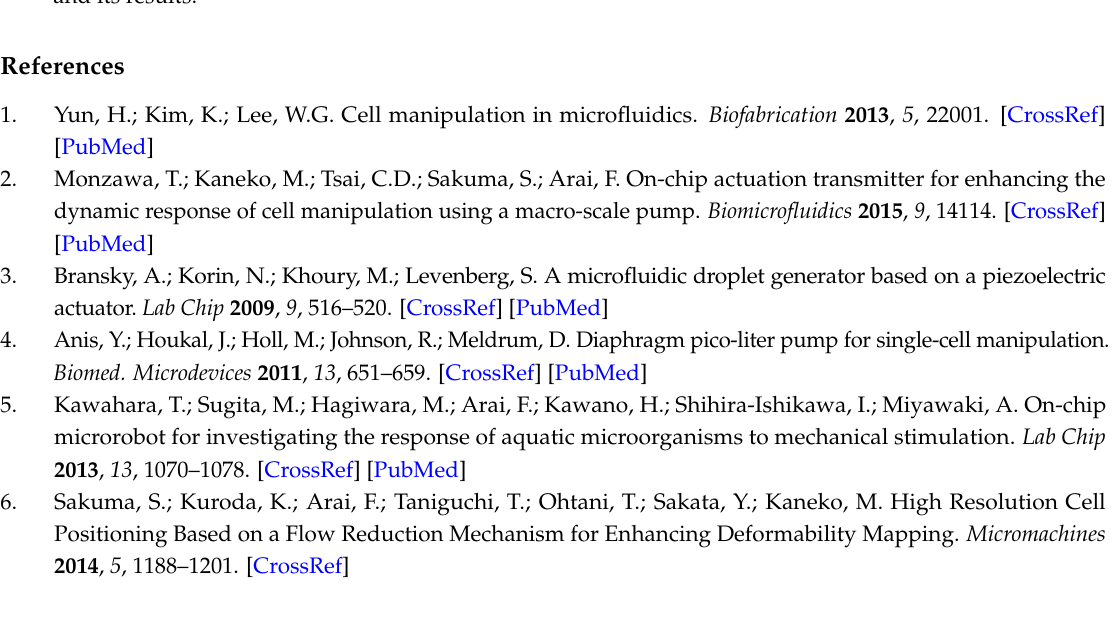
Figure A1. An example of how the gain and phase are determined using fast Fourier transform (FFT) and its results.